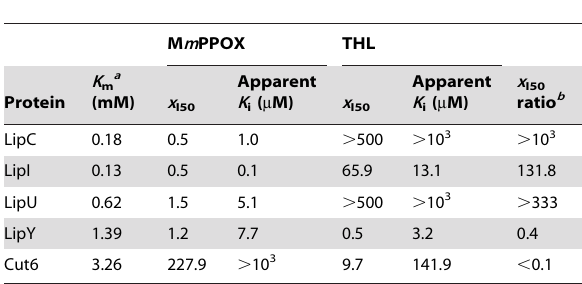
Table 3. Inhibition constants of M m PPOX and THL.